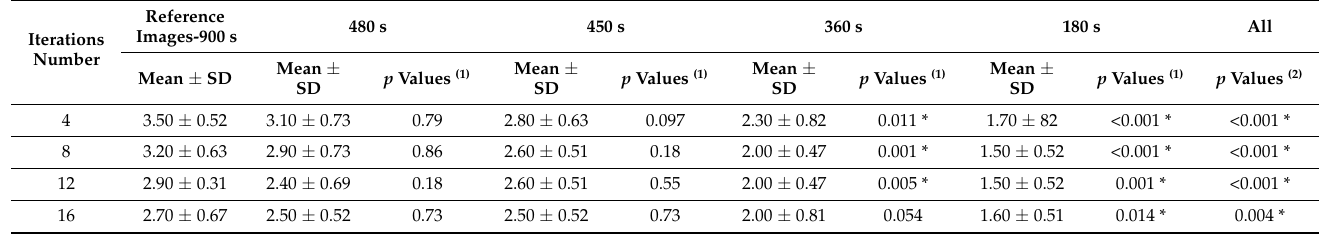
Table 3. Image quality scores by 4-point Likert scale across 2 readers for different acquisition